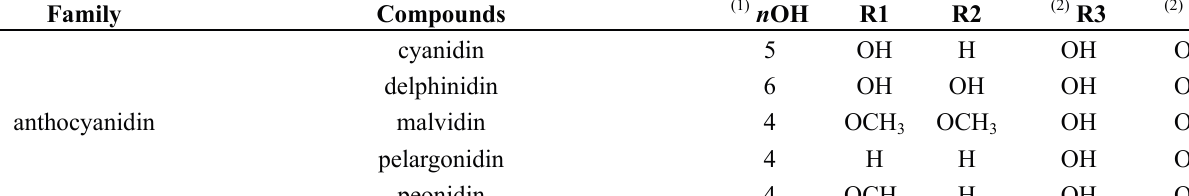
Table 4. Evaluated anthocyanidins and